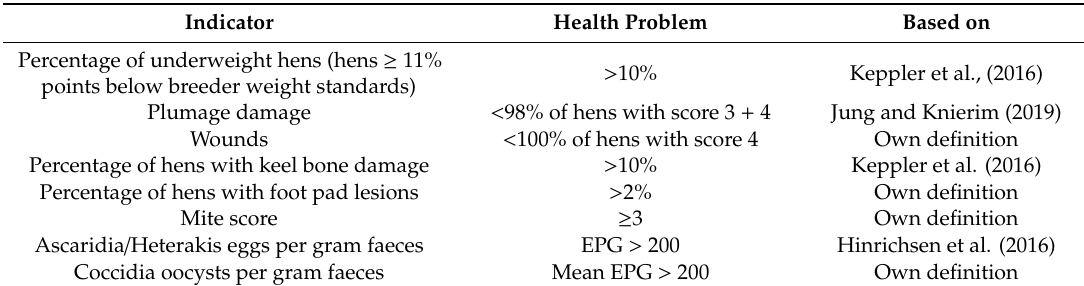
Table 2. Criteria for the presence of health problems in a flock.